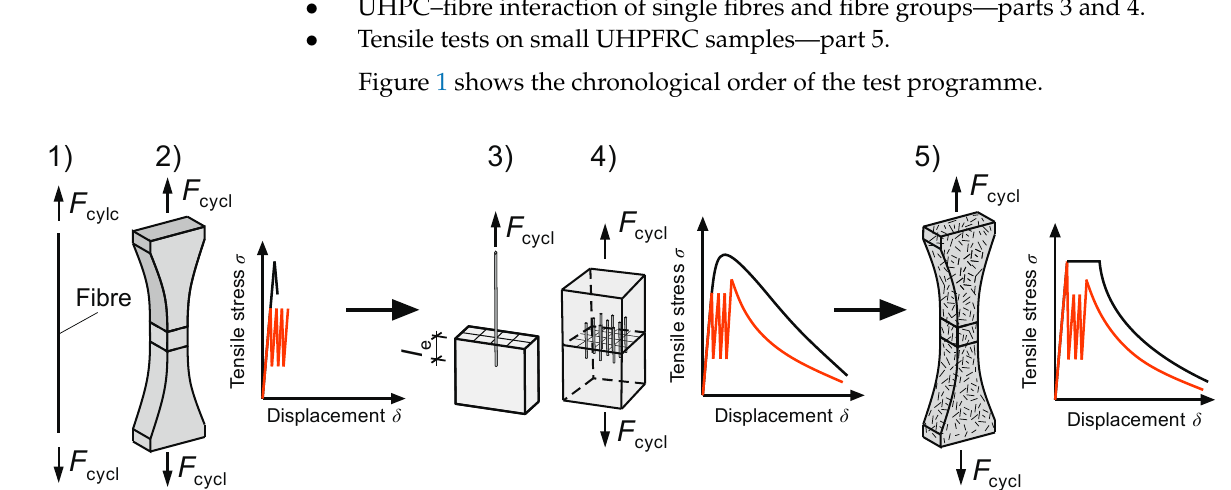
Figure 1. Investigation strategy with the consecutive structured test programme.